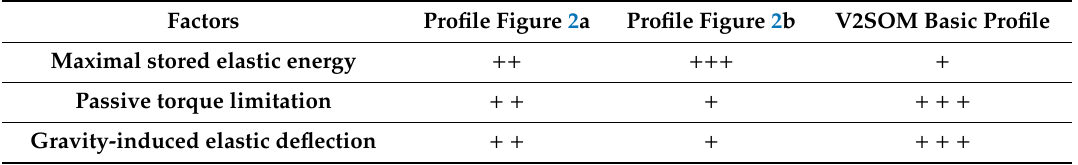
Table 2. Results of a comparative analysis of different VSAs’ basic torque curves. Factors Profile Figure 2a Profile Figure 2b V2SOM Basic Profile